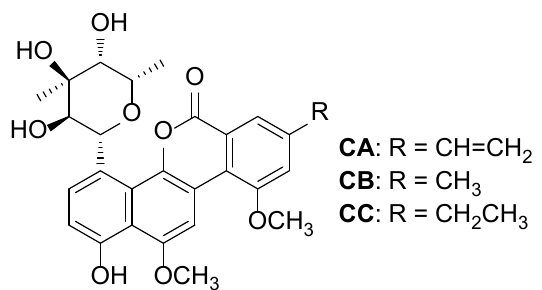
Figure 1. Chemical structures of chrysomycins A-C (CA-CC).